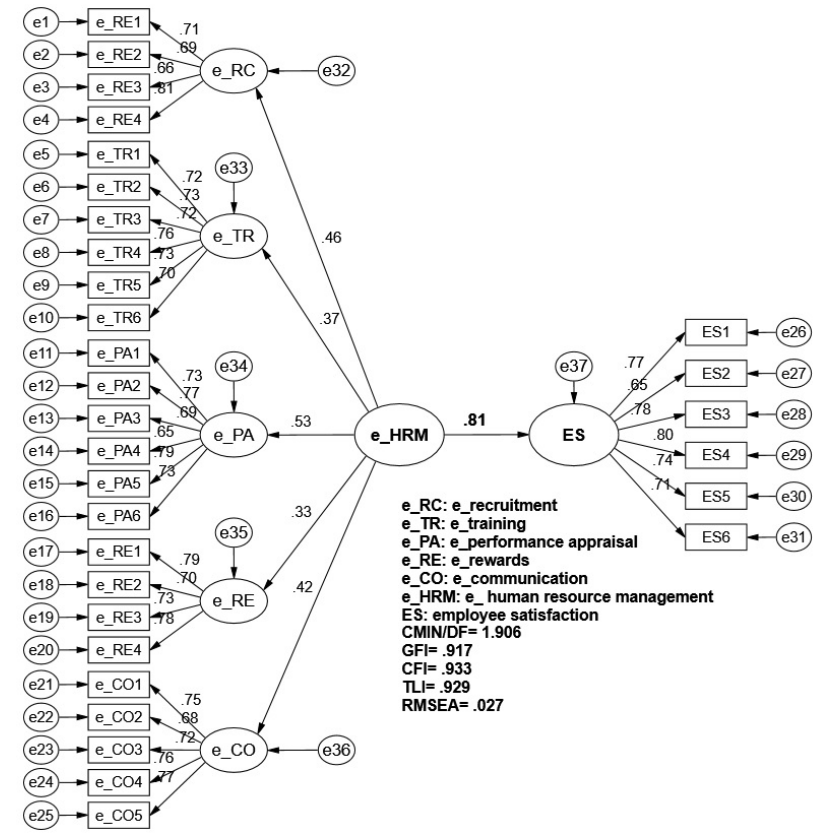
Fig. 2. SEM results of the e-HRM effect on ES